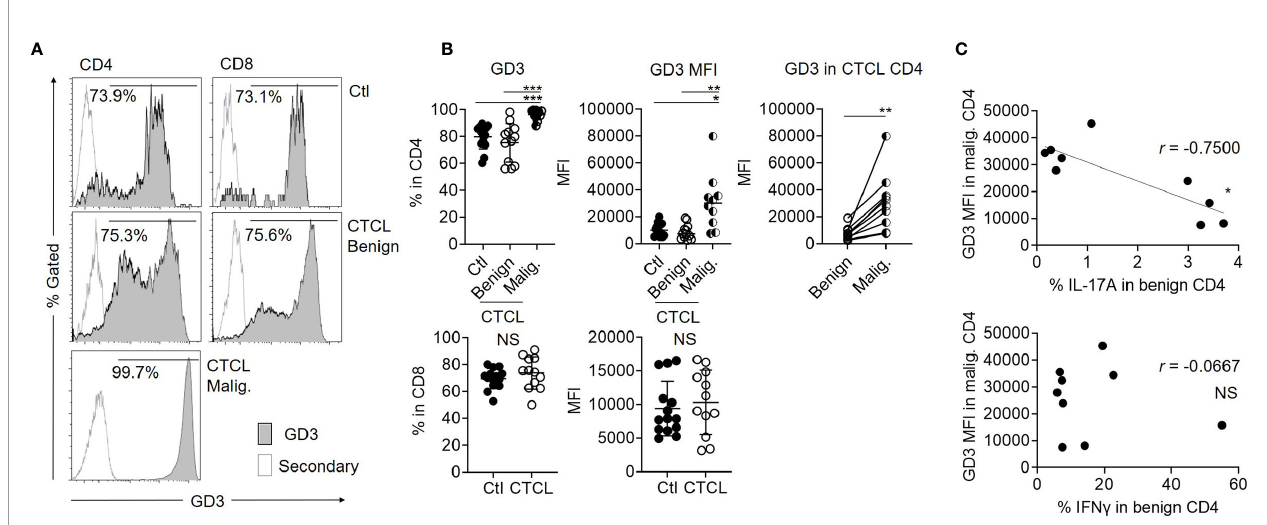
FIGURE 2 | Malignant T cells from CTCL lesions express higher ganglioside GD3 compared to their benign counterparts and controls. (A) Representative histograms for GD3 expression of Ctl T cells, benign, and malignant T cells from CTCL lesions. Empty histograms indicate the controls stained by secondary antibody. (B) Left: Graphs of the accumulated data showing the ratio of GD3 expressing cells in CD4 (top) and CD8 (bottom) fractions of Ctl, CTCL benign fraction, and malignant fraction. N = 14 in Ctl, n = 12 in CTCL benign, n = 10 in CTCL malig. Data on CTCL malignant were excluded when the analyzed cell number was below 100. Middle: MFI of GD3 in CD4 (top) and CD8 (bottom) fractions of Ctl, CTCL benign fraction, and malignant fraction. N = 14 in Ctl, n = 12 in CTCL benign, n = 10 in CTCL malig. Right; MFI of GD3 compared between the benign and malignant CD4 T cells from the same CTCL lesions. N = 10. (C) Correlation between the MFI of GD3 in CTCL malignant T cells and the production ratio of IL-17A (top) and IFN g (bottom) from CTCL benign CD4 T cells. N = 9. * p < 0.05, ** p < 0.01, *** p < 0.001. NS, not signi fi cant.